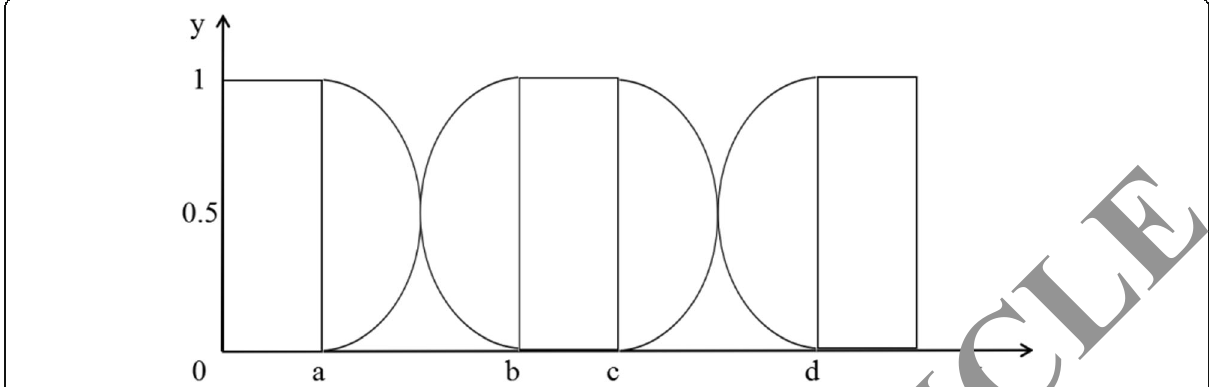
Fig. 4 An example diagram of membership function of uncertain attributes